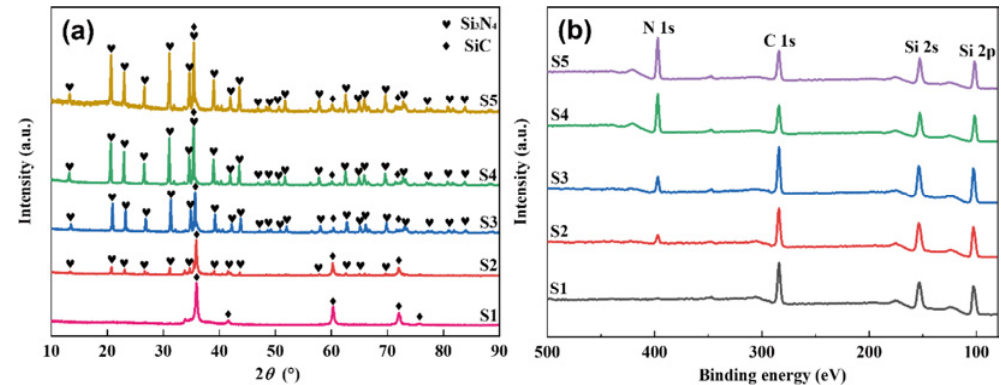
Fig. 2 (a) XRD patterns of SiC/Si 3 N 4 composite aerogels. (b) XPS full spectra of SiC/Si 3 N 4 composite aerogels.